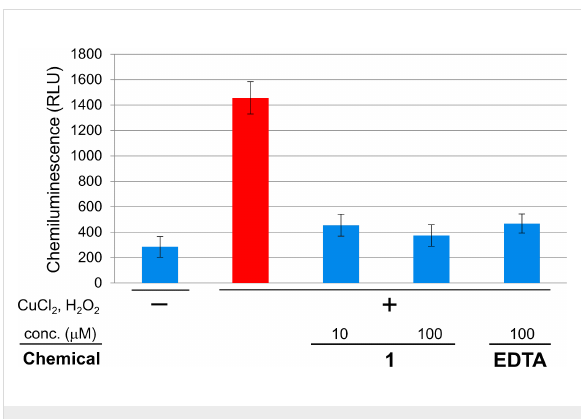
Figure 3: Extinction of luminol chemiluminescence by 1 .